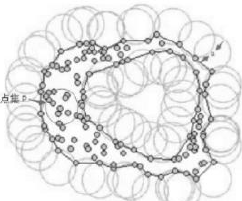
Figure 4 . Schematic diagram of the alpha shape algorithm alpha-shape reconstruction effects: Figure 5 shows